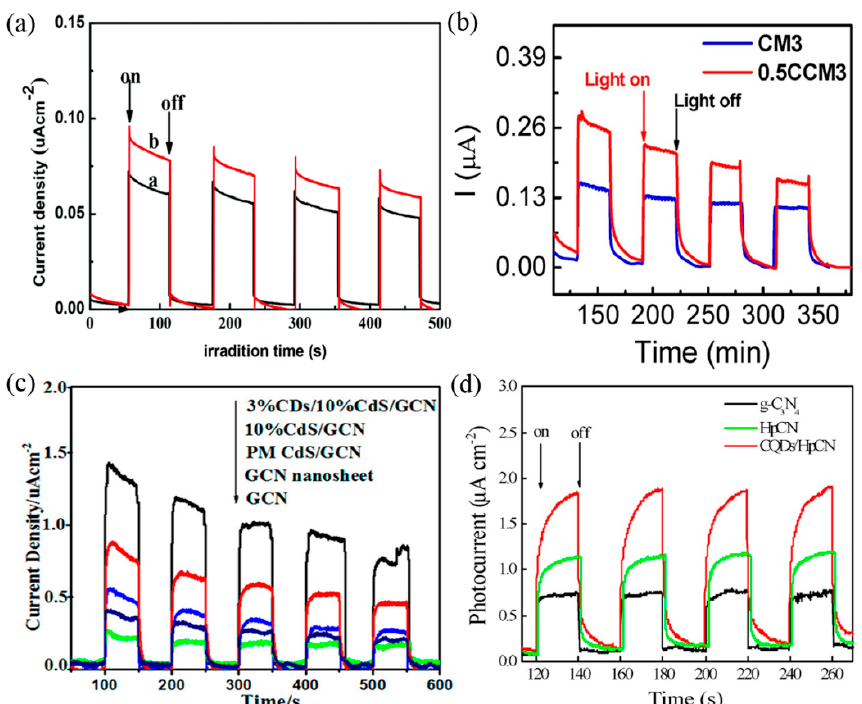
Figure 5. Transient photocurrent responses of ( a ) g-C 3 N 4 and CDs/g-C 3 N 4 (10 wt.%), ( b ) CM3 and 0.5CCM3, ( c ) GCN, GCN nanosheet, PM CdS/GCN, 10%CdS/GCN and 3%CDs/10%CdS/GCN, ( d ) g-C 3 N 4 , HpCN and CQDs / HpCN (reproduced with permission from [92,100,105,106]. Copyright Royal Society of Chemistry, 2017; Elsevier, 2018; American Chemical Society, 2018; Elsevier, 2016; respectively).